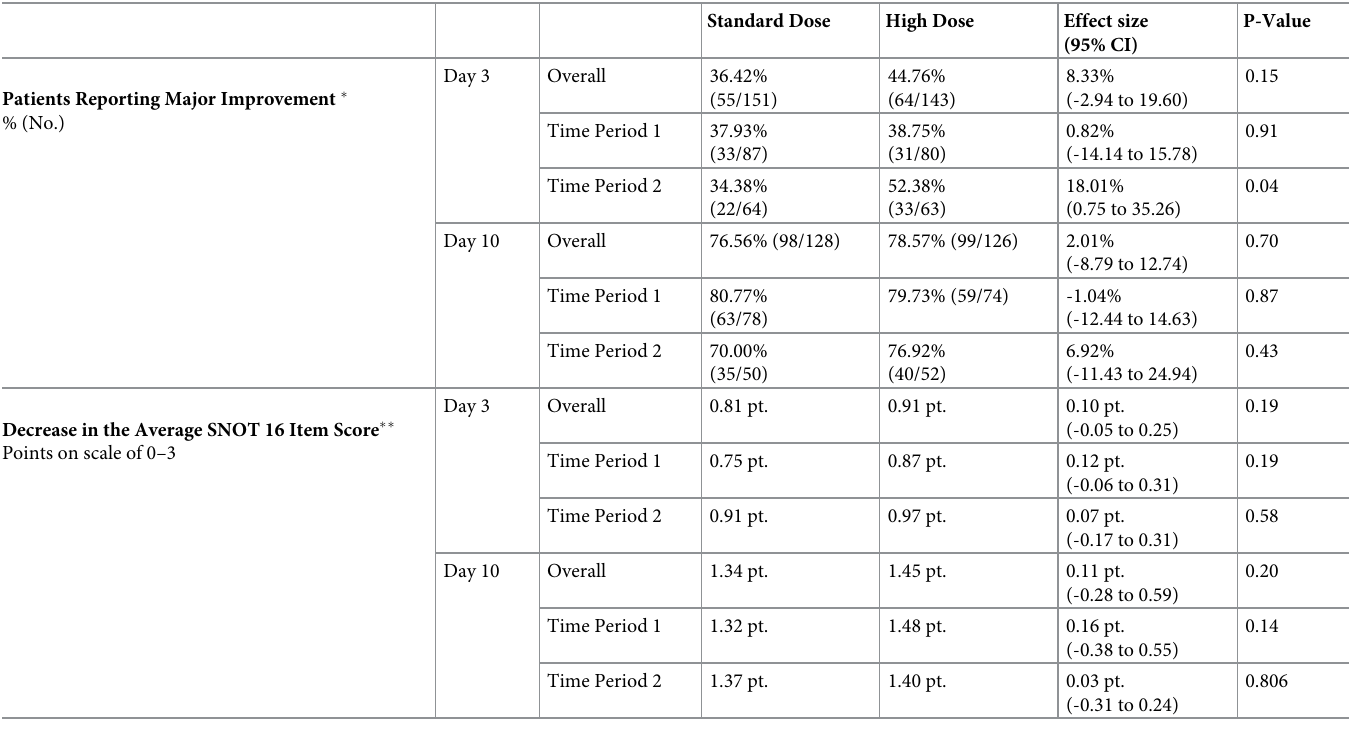
Standard Dose High Dose Effect size